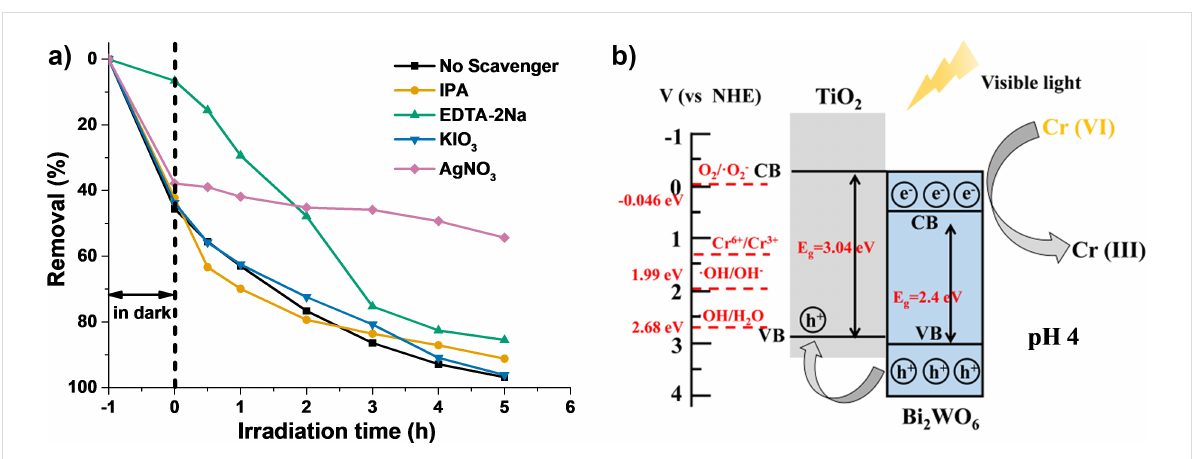
Figure 11: (a) Visible-light- induced ( λ > 420 nm) photocatalytic reduction profiles toward the Cr(VI) pollutant solution (10 mg·L − 1 , pH 4) where IPA, EDTA-2Na, KIO 3 , and AgNO 3 were added. The hierarchical 70% − Bi 2 WO 6 /TiO 2 -NT nanocomposite was used as the photocatalyst. (b) Schematic illustration of the photocatalytic reduction mechanism toward the Cr(VI) pollutant (pH 4) by the hierarchical Bi 2 WO 6 /TiO 2 -NT nanocomposite under visible light ( λ > 420 nm)